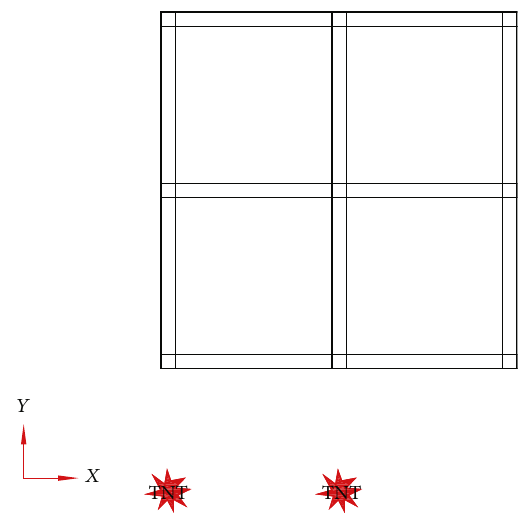
Figure 4: The position of explosives in X-Y plane.